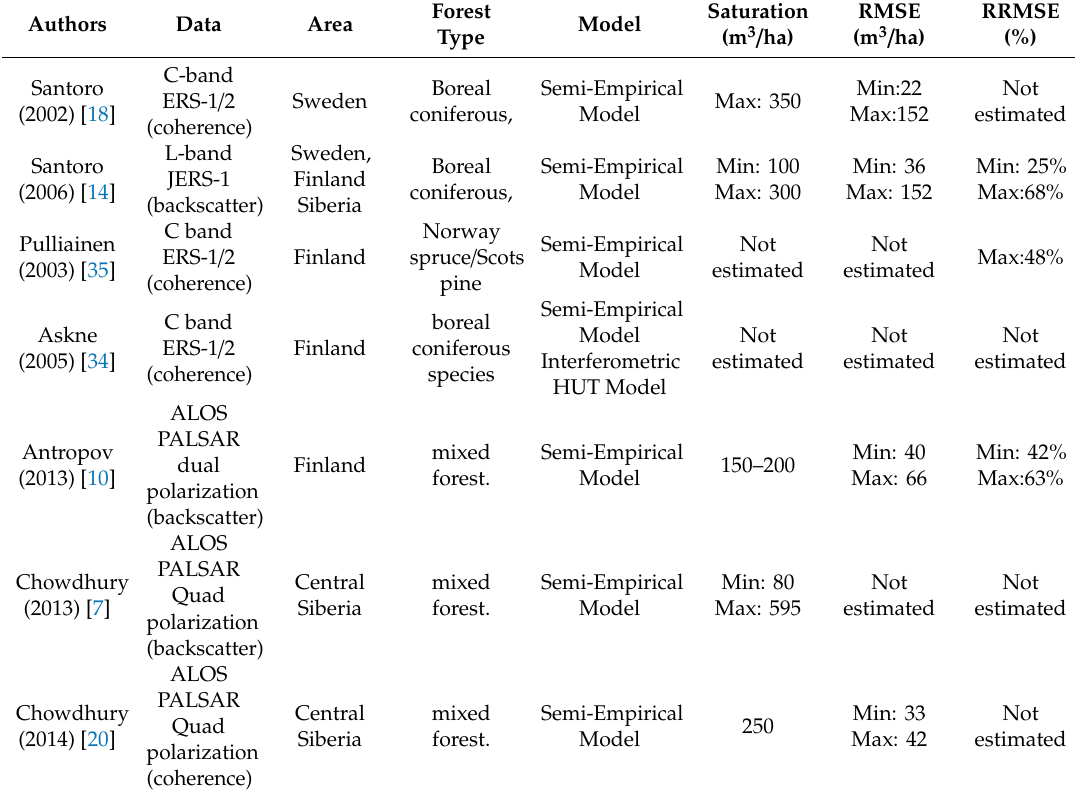
Table 1. Previous studies investigating the potential of growing stem volume (GSV) saturation using synthetic aperture radar (SAR)